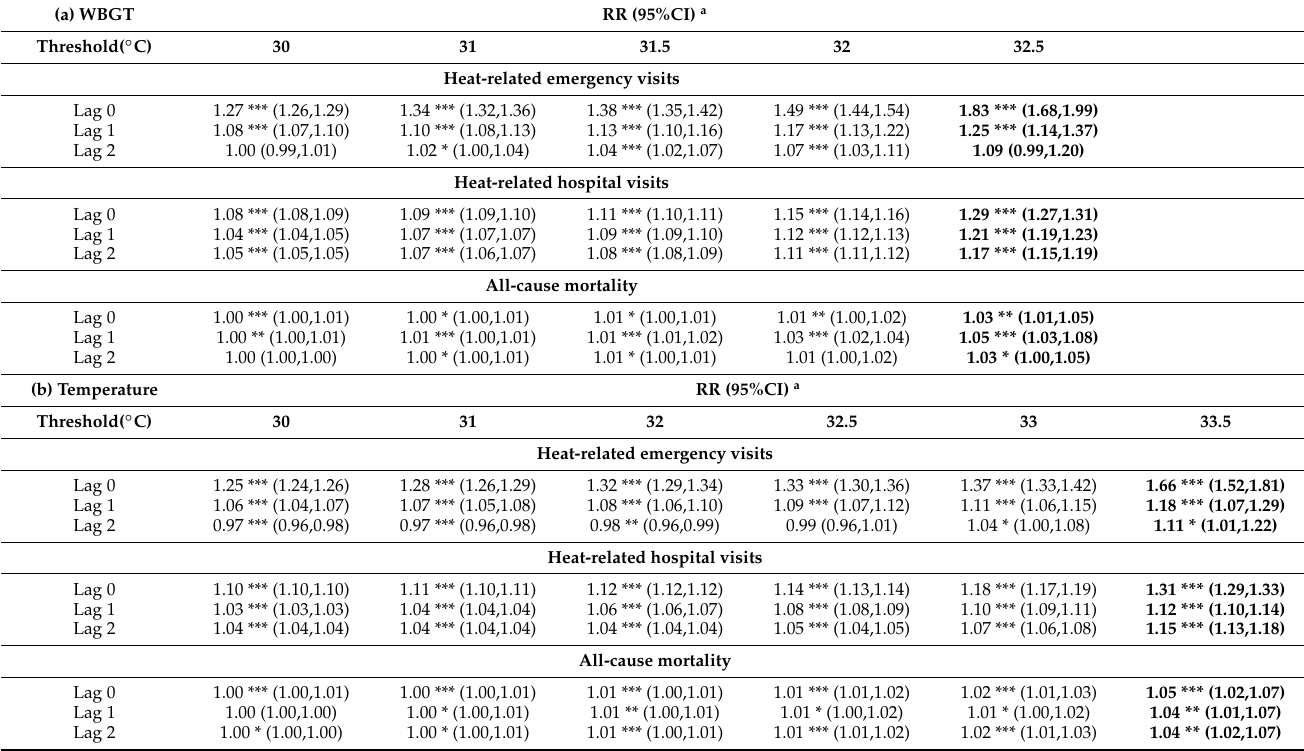
Table 3. Relative risks (RRs) at different (a) WBGT and (b) temperature threshold candidates for the whole of Taiwan. (a)